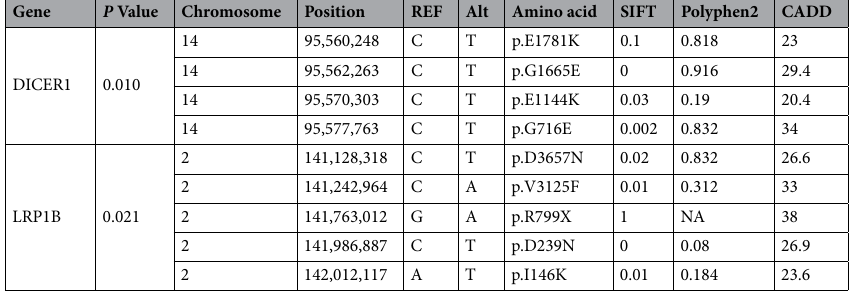
Table 2. Altered variants of SKAT-O Significant Genes (DICER1, LRP1B) in paired samples. Ref reference base, Alt alternative base, SIFT sorting intolerant from tolerant, CADD combined annotation dependent depletion.